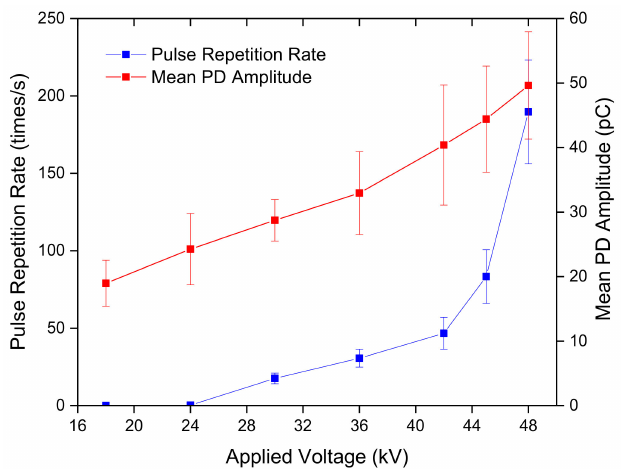
Figure 9. PD parameters under AC/DC proportion of 1:5.